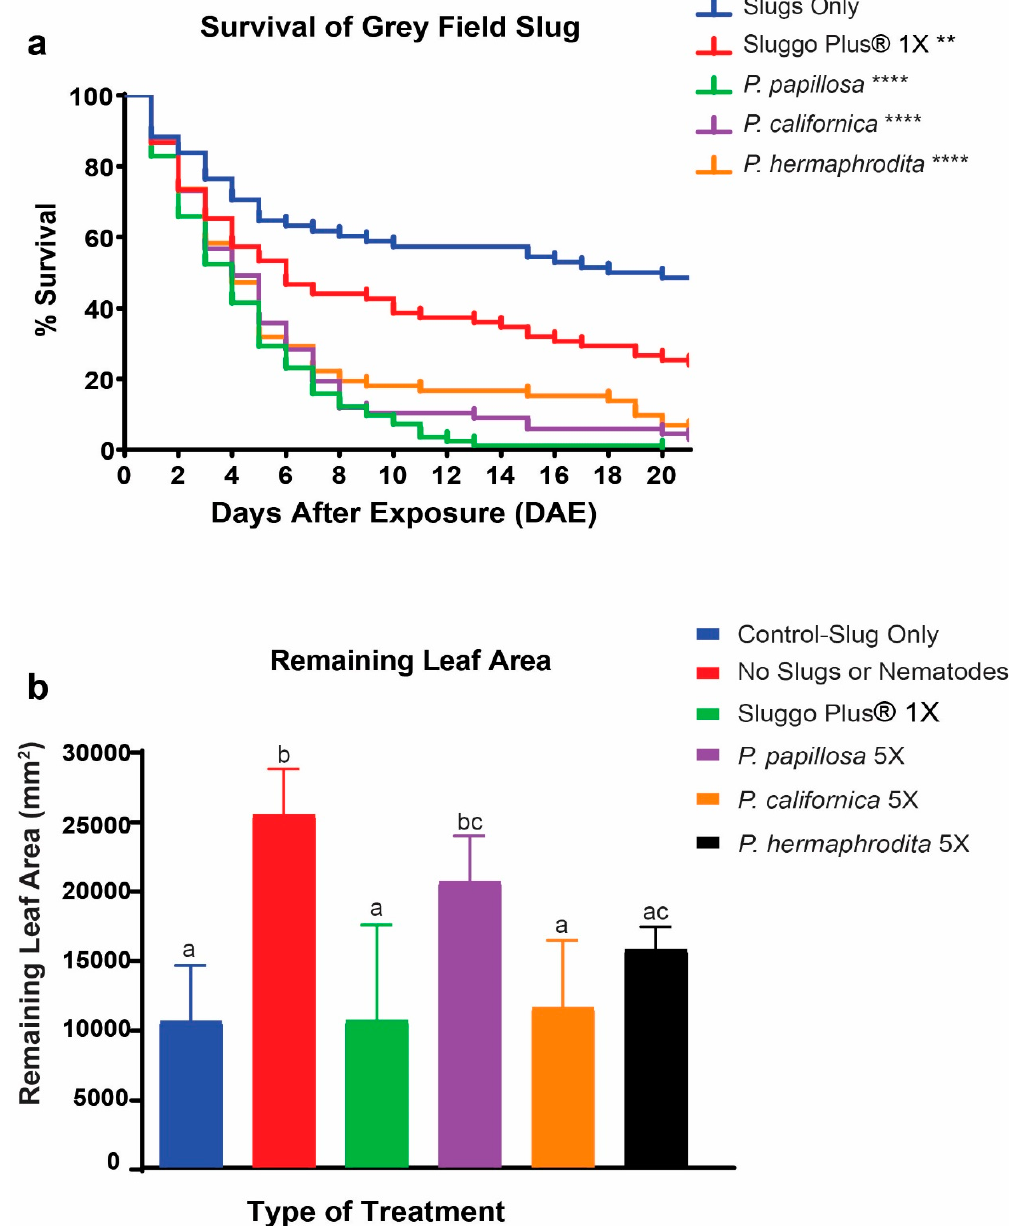
Figure 2. ( a ) Percentage survival of Deroceras reticulatum exposed to three species of Phasmarhabditis ( P. californica, P. hermaphrodita and P. papillosa ), compared with Sluggo Plus ® (iron phosphate and spinosad). P. papillosa caused an average of 97.5% mortality (SEM = 0.01), P. hermaphrodita caused an average of 81.4% mortality (SEM = 0.09), P. californica caused an average of 77.2% mortality (SEM = 0.05), Sluggo Plus ® caused an average of 68.6% mortality (SEM = 0.05), and the slug only control had an average of 41.9% mortality (SEM = 0.06). ** indicates a p value of < 0.01, *** indicates a p value of < 0.001 and **** indicates a p value < 0.0001 compared to the slug only control ( b ). Average remaining leaf area (mm 2 ) of Canna ‘Cannova ® Bronze Scarlet Canna Lily’ after 21 days after exposure (DAE) to Phasmarhabditis treatment, compared with Sluggo Plus ® treatment and controls. Picture was taken 21 DAE in trial 1 of the lath house experiment. Shared letters indicate the absence of significant differences whereas treatments not sharing letters significantly differ from one another. Log rank analyses were used, comparing each treatment to one another in panel A. A one-way ANOVA utilizing Tukey’s multiple comparisons test was used for panel